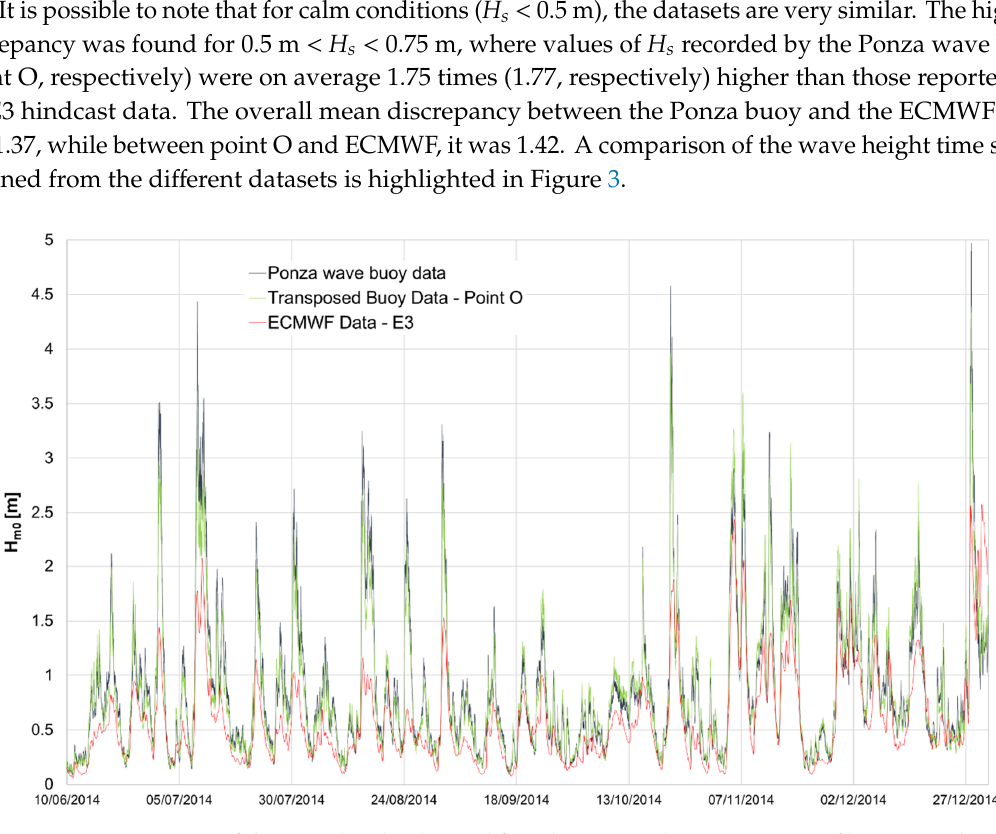
Figure 3. Comparison of the wave height obtained from buoy records, transposition of buoy records at point O and ECMWF data for the reference point E3.